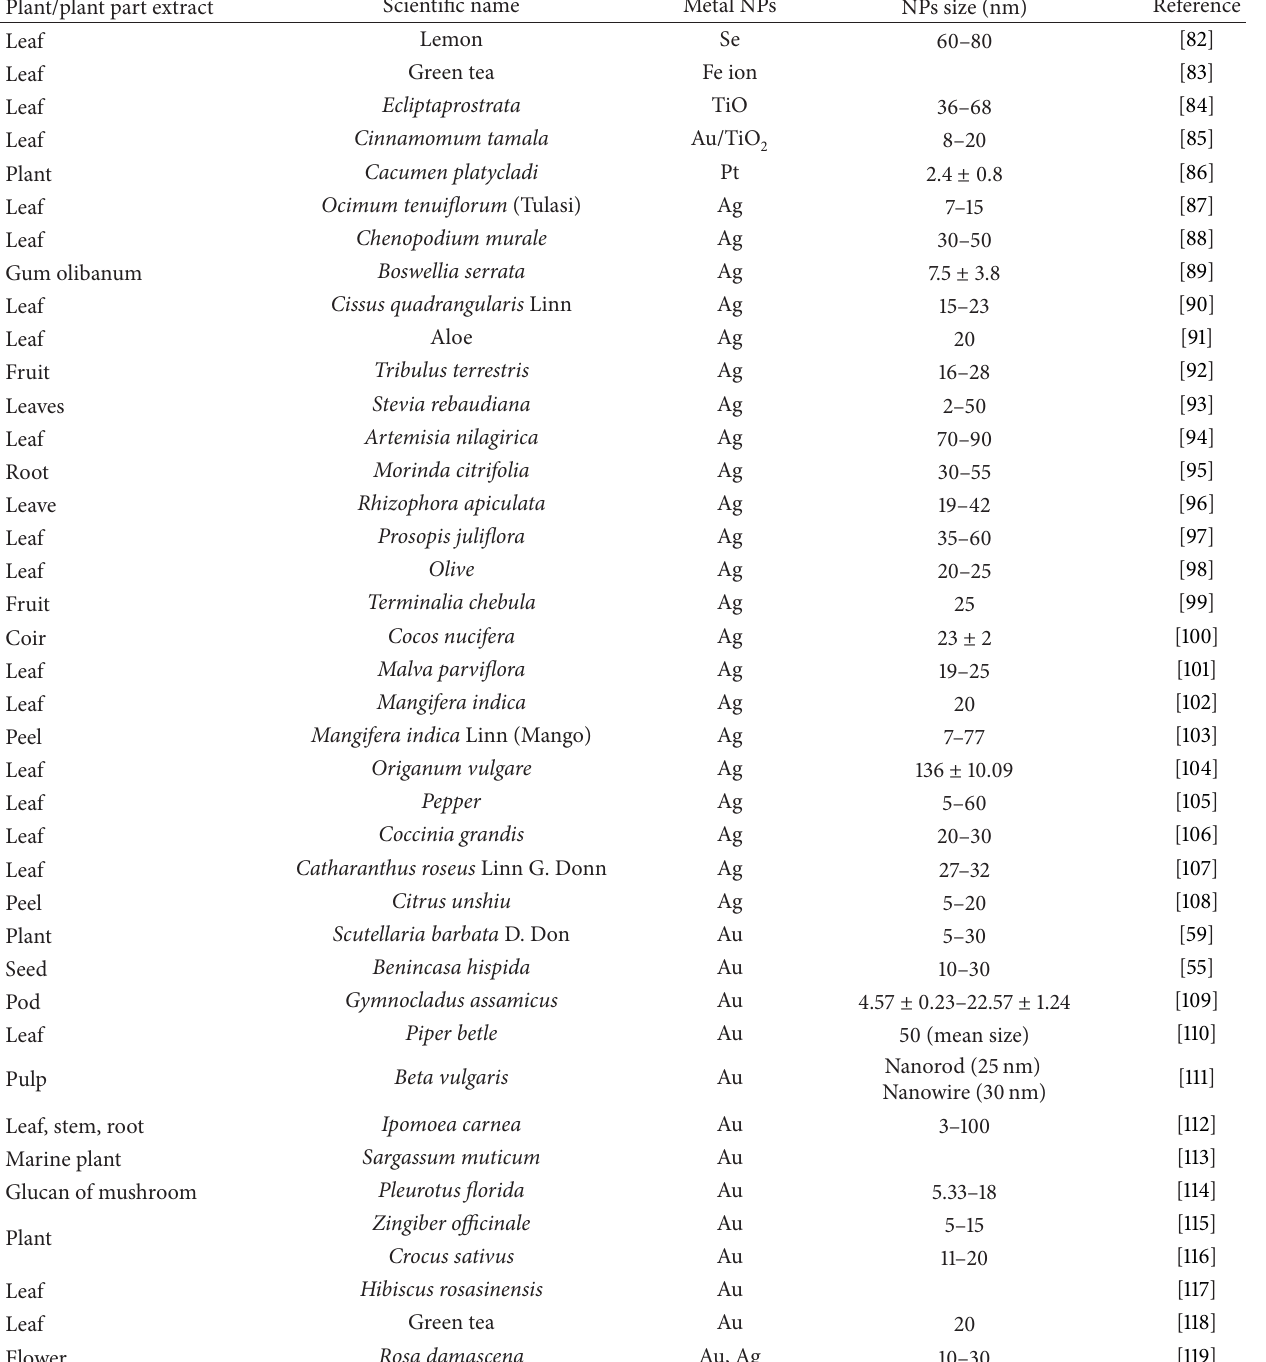
Table 2: Plant extract-based biosynthesis of metal or metal-based ion